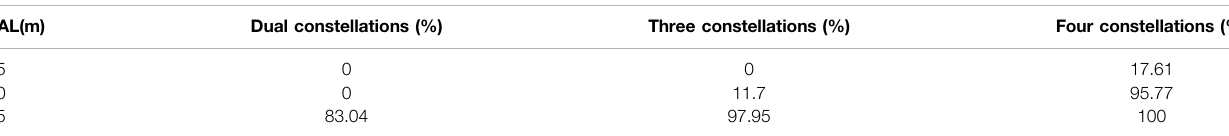
TABLE 4 | Availability analysis of the multi-constellation integrity algorithm before